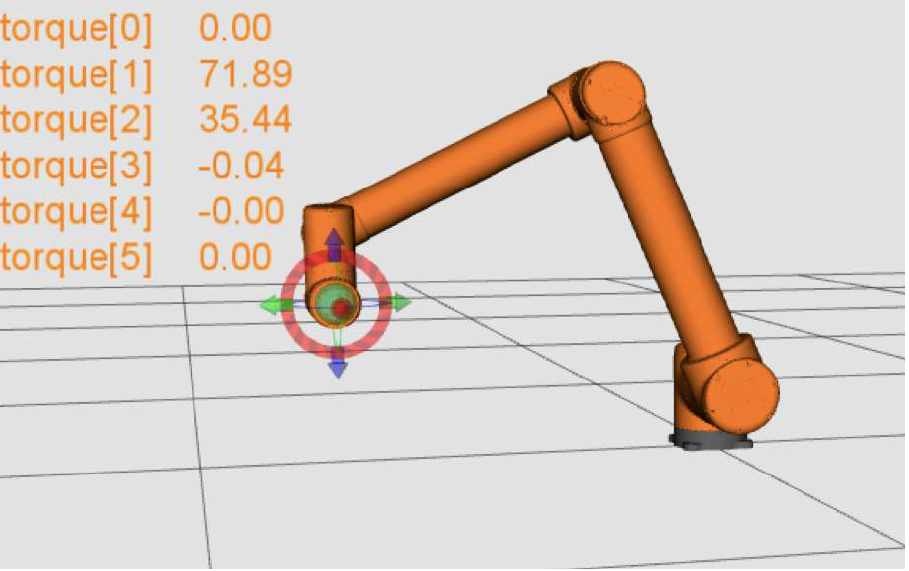
Figure 2. Schematic overview of the UR10 robot—CAD model.